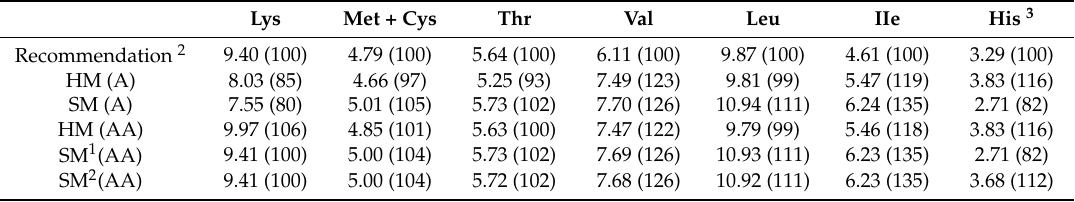
Table 4. Recommended and achieved AA supply 1 (in g/kg as-fed resp. percent of the recommendation) in growing pig